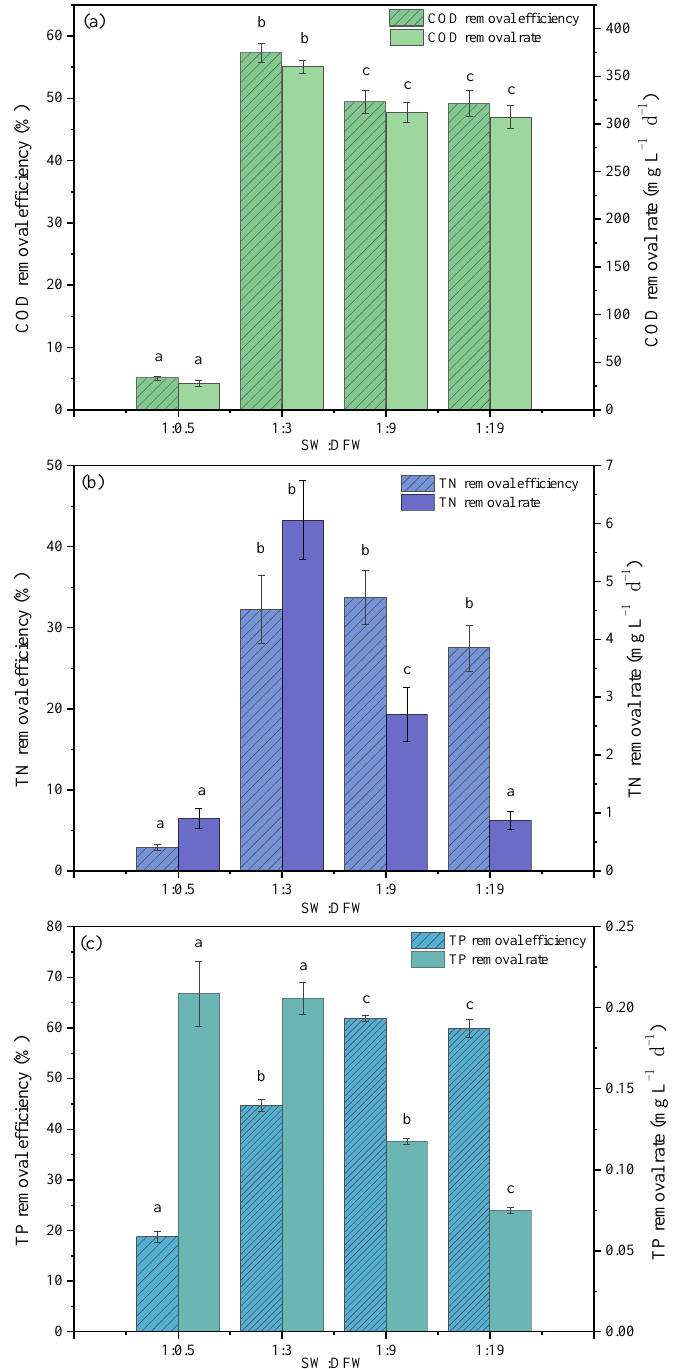
Figure 3. Removal efficiency and rate of COD ( a ), TN ( b ) and TP ( c ) in mixed wastewater with different ratios of swine wastewater (SW) to diluted furfural wastewater (DFW). Data are shown as mean ± SD, n = 3. Different letters in the same column represent significant differences ( p ≤ 0.05).